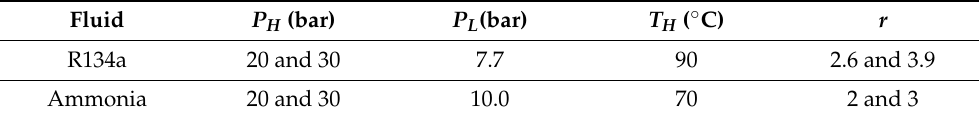
Table 1. Real gases and operating conditions of the